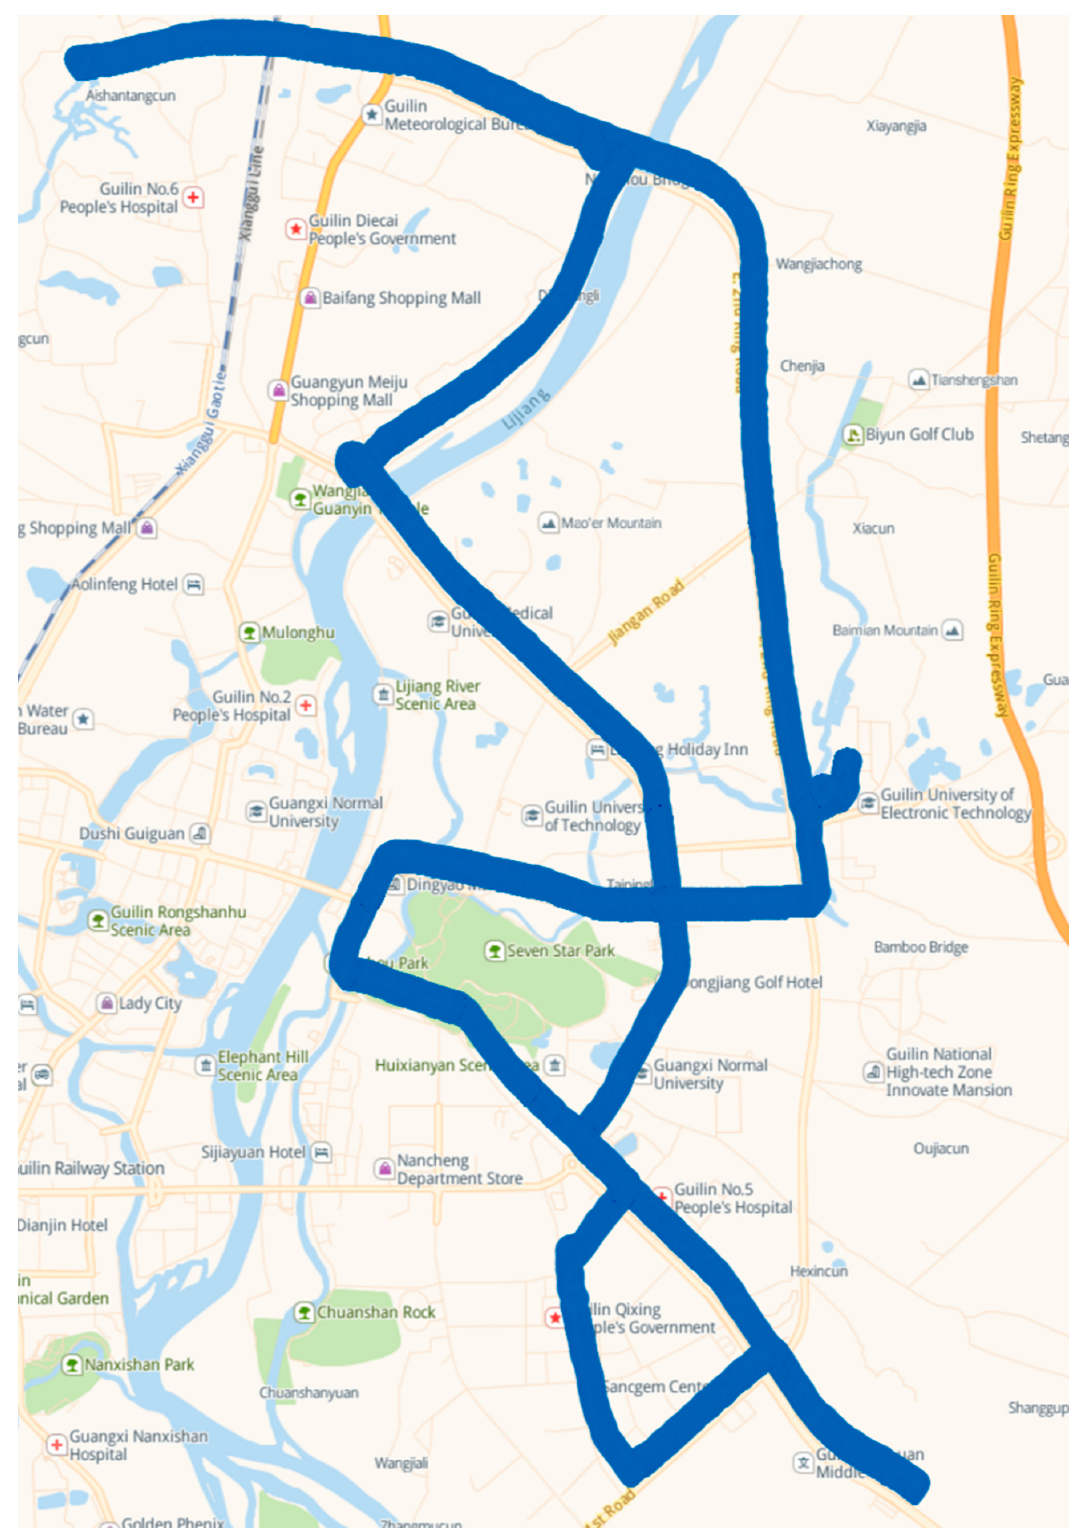
Figure 3. Experiment 1: Vehicle driving trajectory.